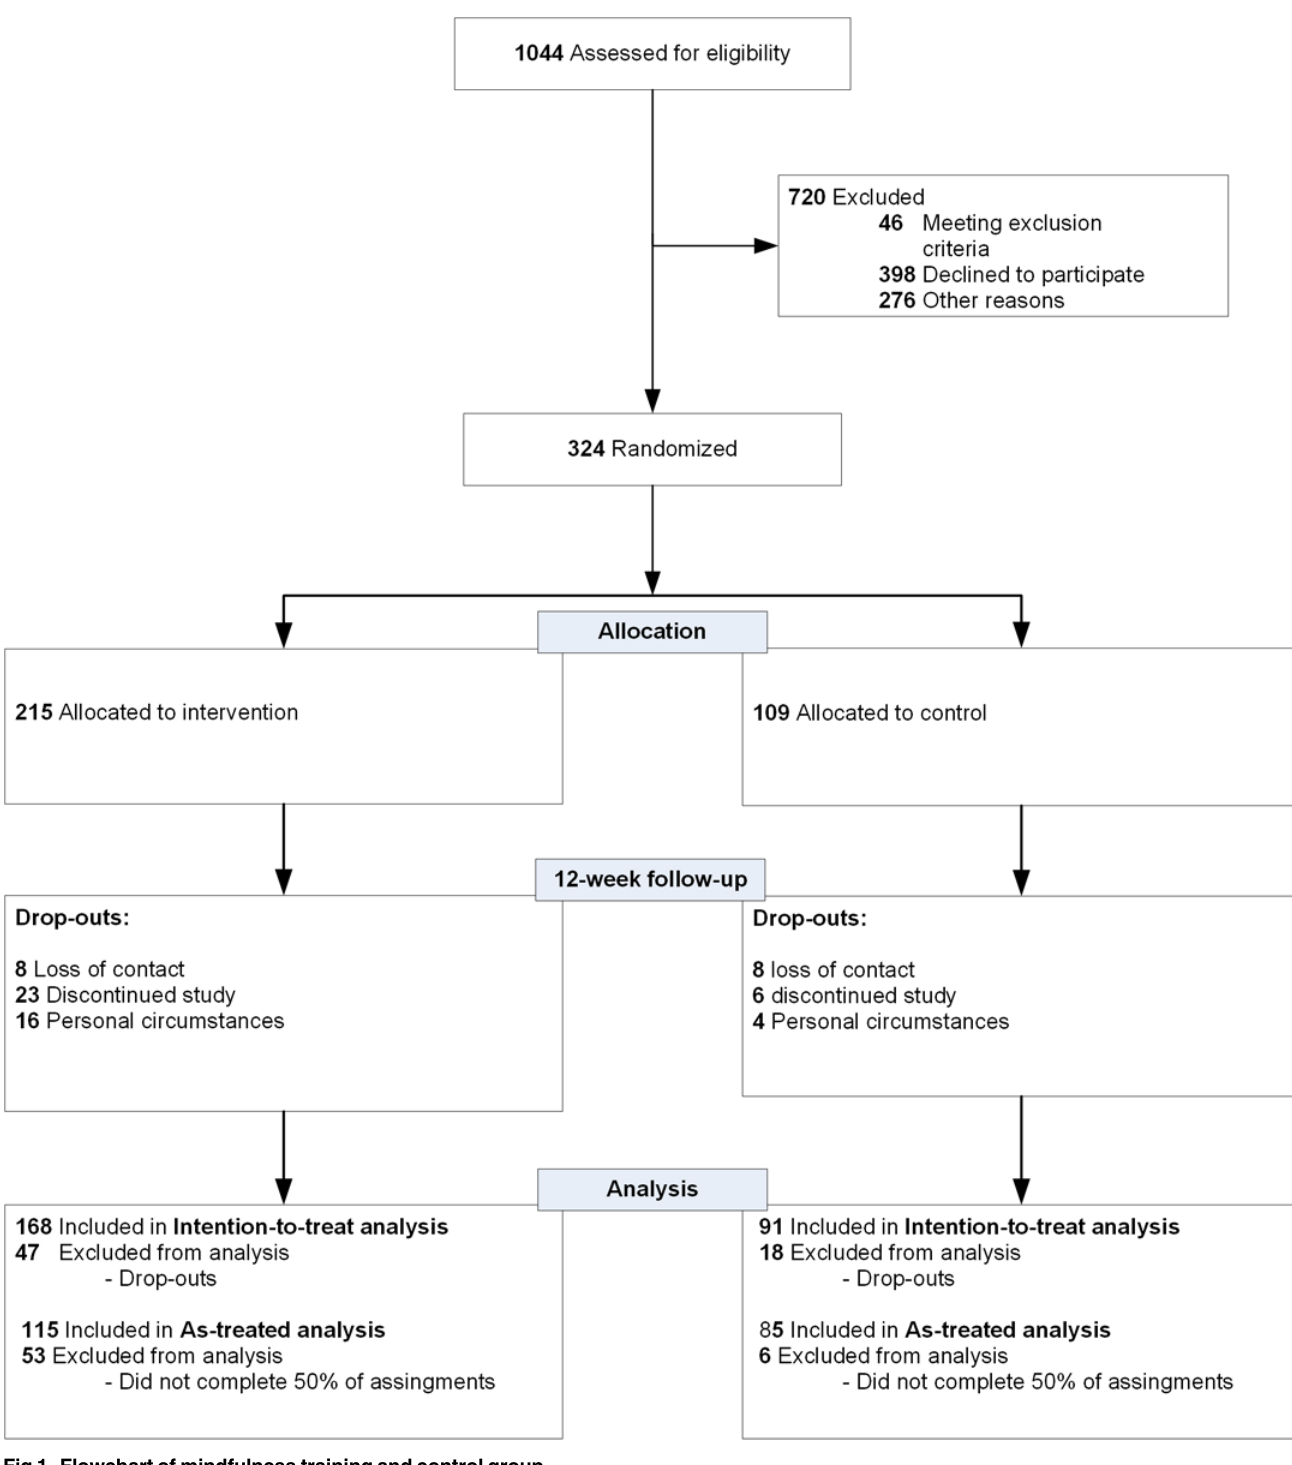
Fig 1. Flowchart of mindfulness training and control